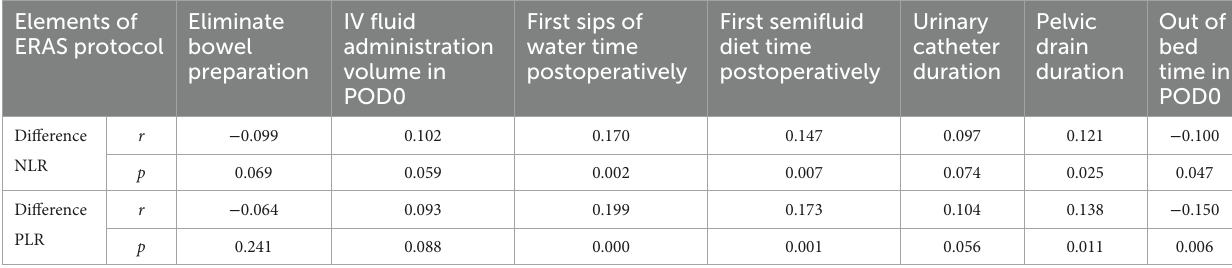
TABLE 5 Correlation analysis between perioperative difference between neutrophil-to-lymphocyte ratio (NLR), platelet-to-lymphocyte ratio (PLR), and elements of ERAS protocol, including elimination bowel preparation time, IV fluid administration volume in postoperative day POD 0, first sips of water